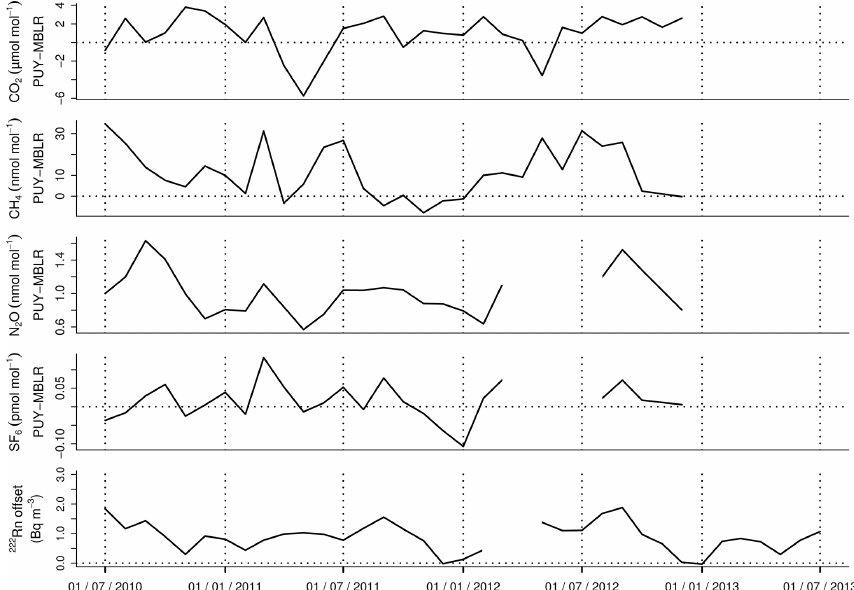
Figure 7. Differences between the monthly background at Puy de Dôme and the respective monthly MBLR (Dlugokencky et al., 2013a, b) at 45.5 ◦ N latitude for CO 2 , CH 4 , N 2 O and SF 6 . The last panel is the 222 Rn offset relative to marine